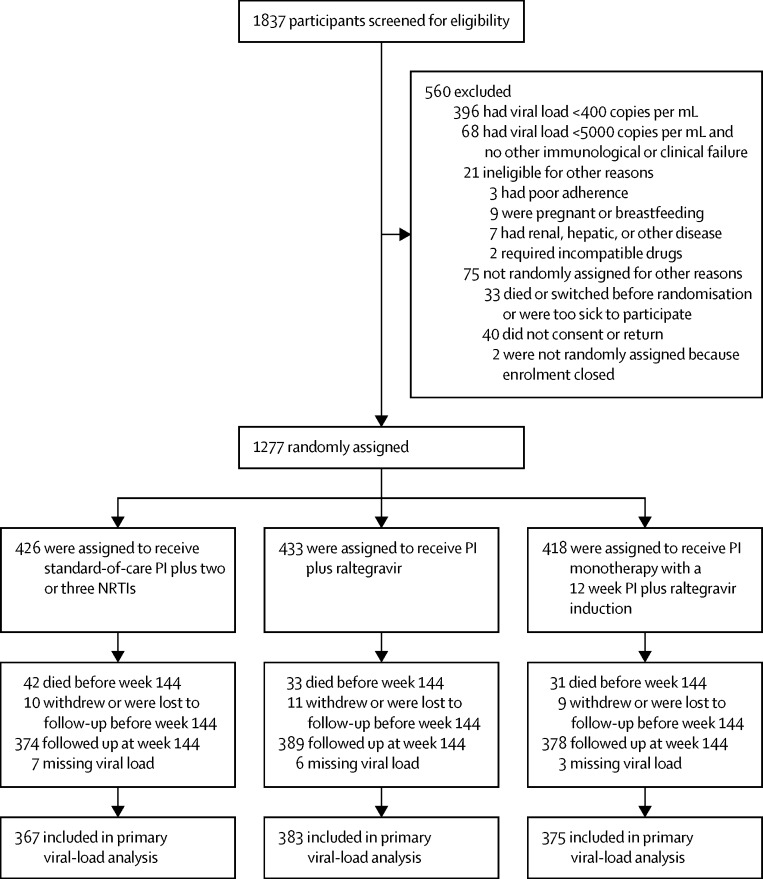
Trial profileNRTIs=nucleoside reverse-transcriptase inhibitors. PI=protease inhibitor.